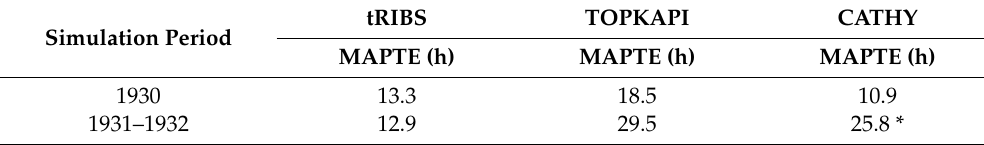
Figure 5. Comparison between the observed flow duration curve (black solid line) and the 90% confidence intervals (gray shading) from the 50 ensemble simulations for the tRIBS ( a ), TOPKAPI ( b ), and CATHY ( c ) hydrologic models for the 1930 period. In the insets, a zoom on the observed and simulated flow duration curve is reported in semi-log scale to better interpret the results. Table 4. Mean absolute peak time error (MAPTE) in unit (h) for the years 1930 (calibration period for tRIBS) and 1931–1932 (validation period for tRIBS). (*) Values obtained with the soil crusting assumption.